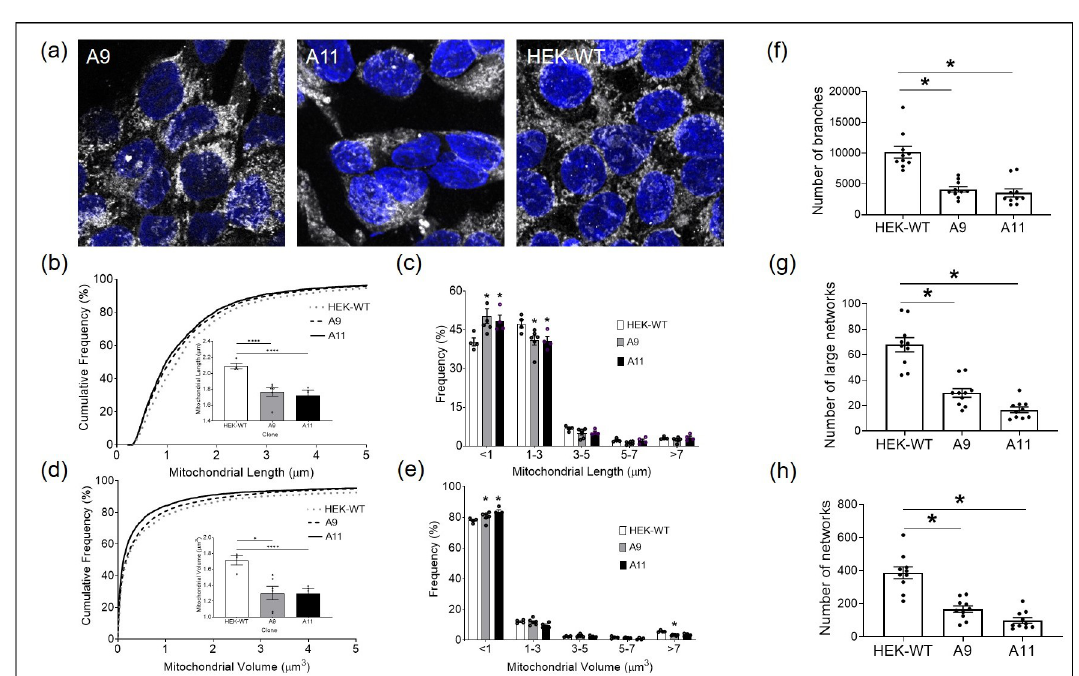
Fig 8. HEK-DP clones demonstrate increased mitochondrial fission. Mitochondrial morphology is assessed using Tomm20 immunostaining (a) in A9, A11, and HEK-WT cells. The frequency of mitochondria under 1 μ m in length is significantly increased in A9 and A11 clones (b and c). Mitochondrial volume is significantly decreased in A9 and A11 compared to HEK-WT (d and e). In addition, the number of branches, large networks, and overall networks are significantly decreased in A9 and A11 (f-h) ( � - p < 0.05; ���� -p <